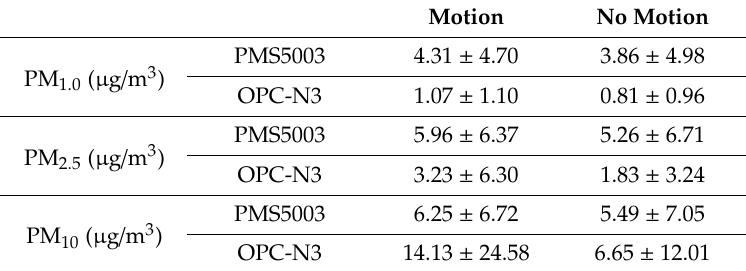
Table 4. Mean PM concentrations recorded with the PMS5003 and OPC-N3 for the periods when the motion was detected or not. The t -test showed that results were statistically significant at the 95% confidence